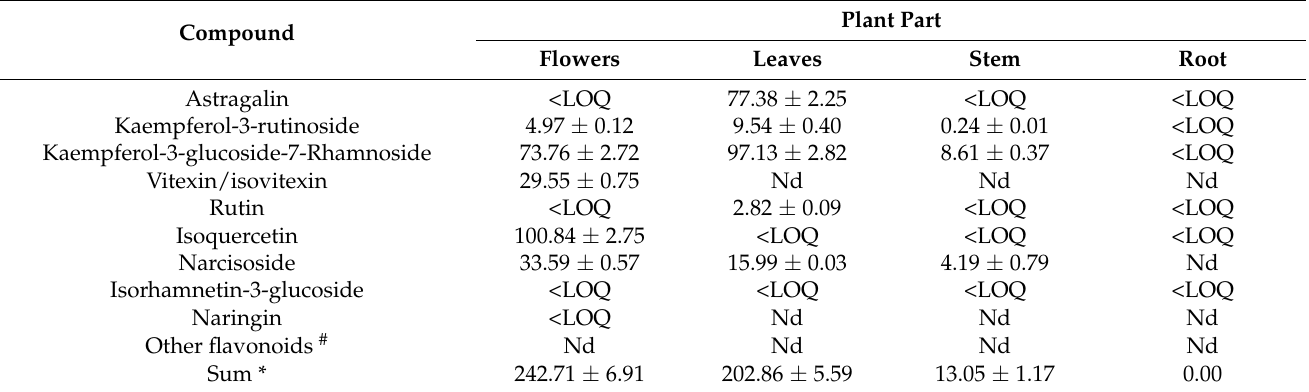
Table 2. Flavonoid contents in different morphological parts of Atriplex sagittata Borkh. [ µ g/ g dw. ±